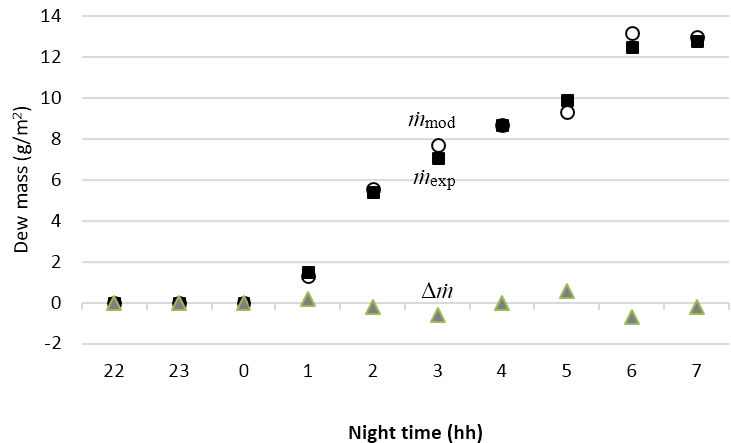
Figure 10. Comparison of the experimental and theoretical dew mass.